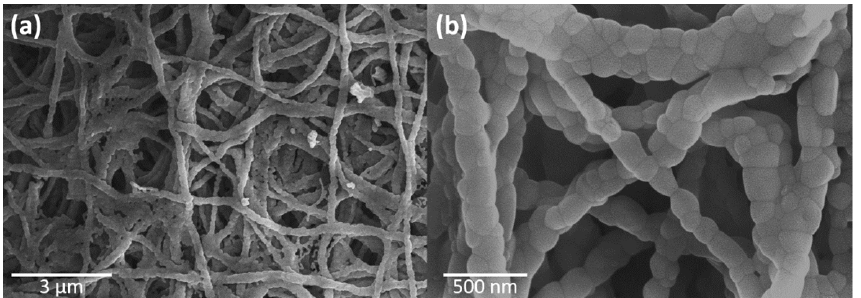
Figure 4. FESEM image of Cu 2 Y 2 O 5 nanofibers with different magnification ( a ) × 10.0 k and ( b ) × 50.0 k .